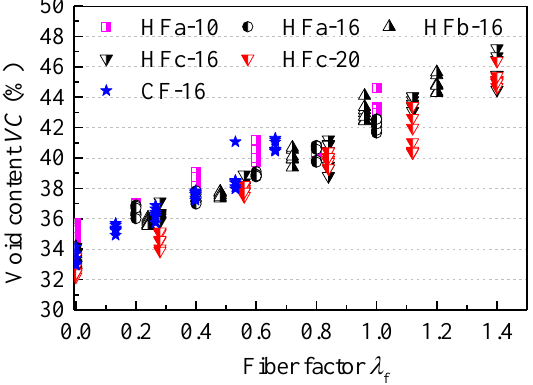
Figure 3. Changes of void content VC with a varying fiber factor λ f. Table 5. Statistical results of the parameter a VC